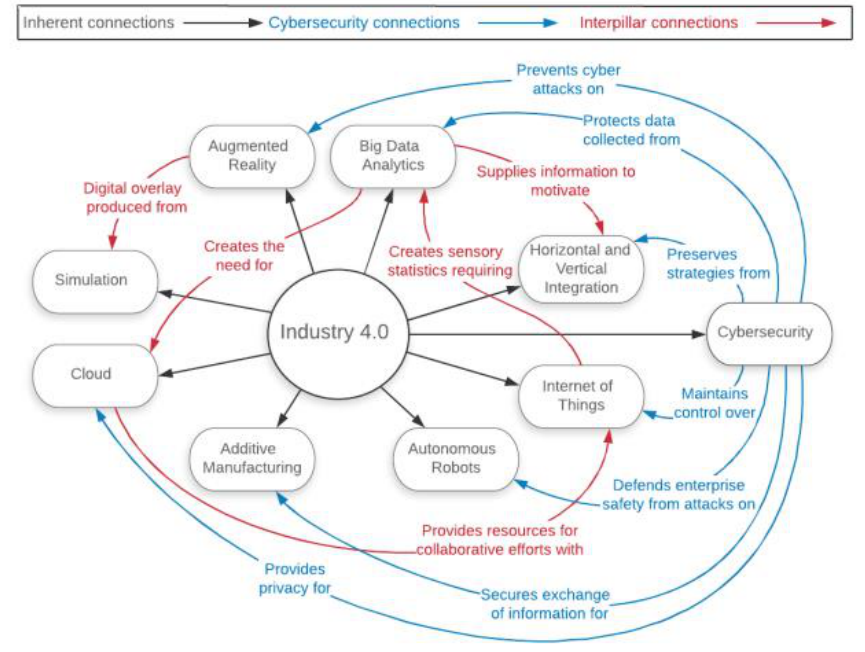
Figure 3. The relationships between the three pillars of connections of I4.0 technologies [52].